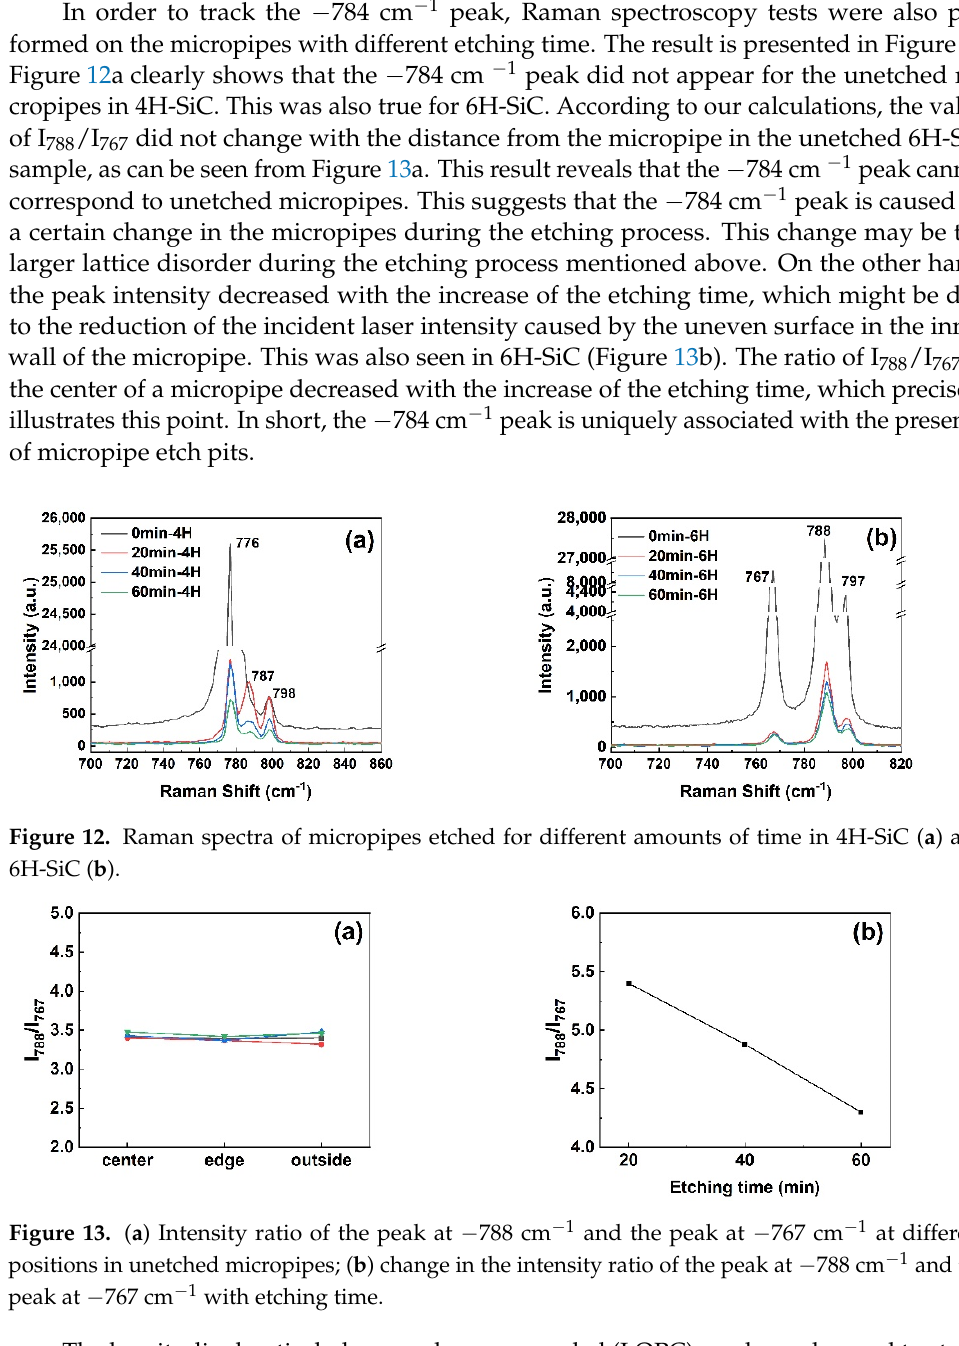
Table 2. LOPC modes and carrier concentrations of different dislocations in 4H-SiC. Defects Types